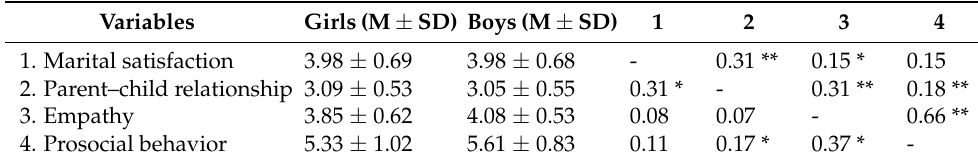
Table 1. Descriptive statistics and correlations among study variables ( N = 480).